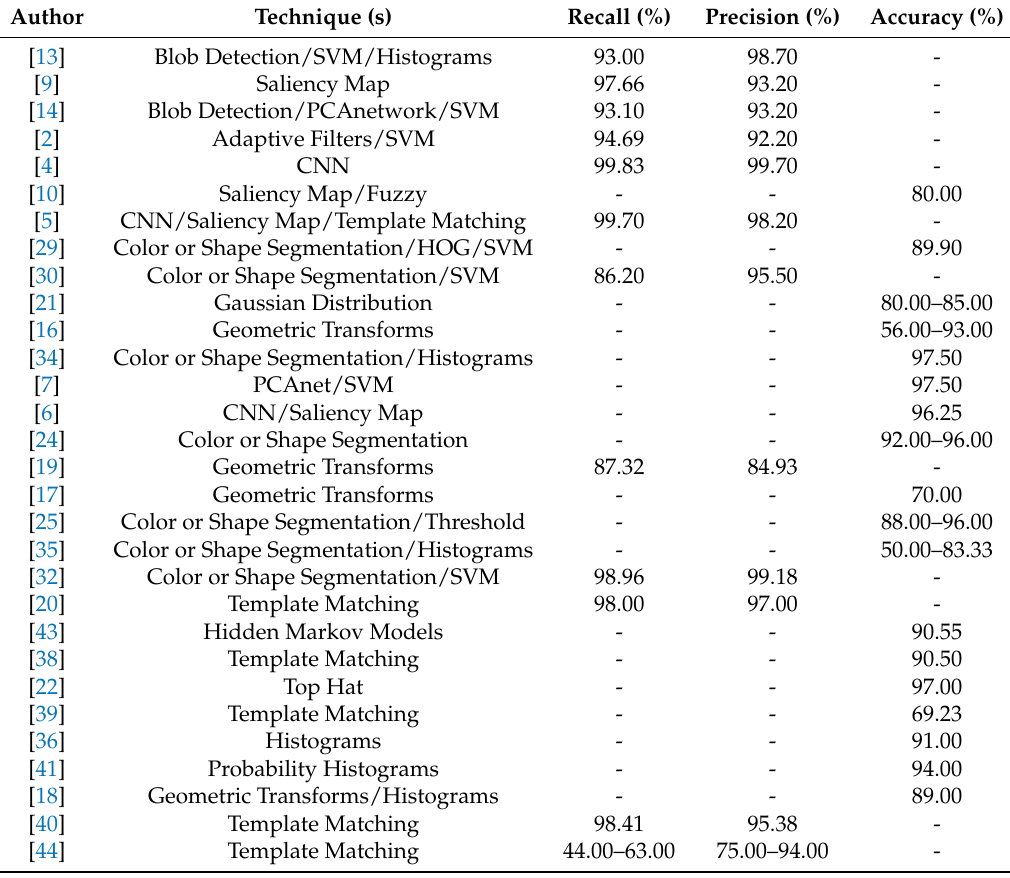
Table 1. Rates achieved by related works and